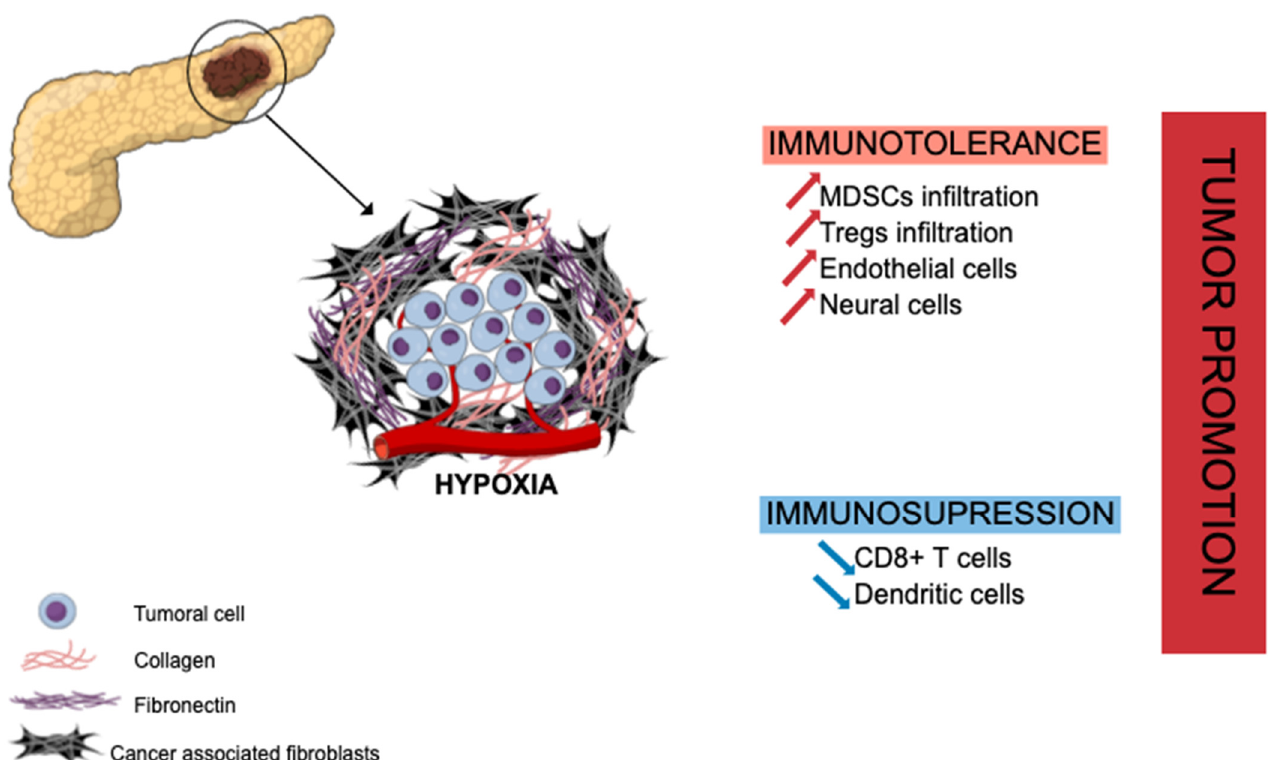
Figure 1. Extracellular matrix in pancreatic ductal adenocarcinoma and tumor growth promotion. Abundant stroma is mainly composed of cancer-associated fibroblasts (CAFs) and collagenous pro- teins leading to hypoxia, immune evasion, and immunotolerant state through recruitment of immu- nosuppressive cells (MDSCs, Tregs) and suppressive effect on effector immune cells (CD8 + T cells, dendritic cells). MDSCs: myeloid-derived suppressor cells; Tregs: regulatory T